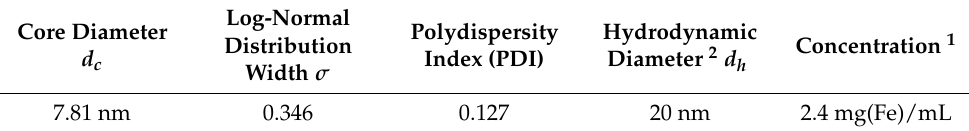
Table 2. Material properties of MNPs from fitting the experimental data with the Langevin model.